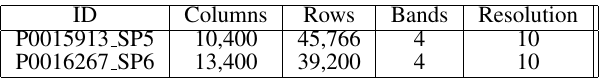
Table 2. Image information used in the cloud segmentation task.